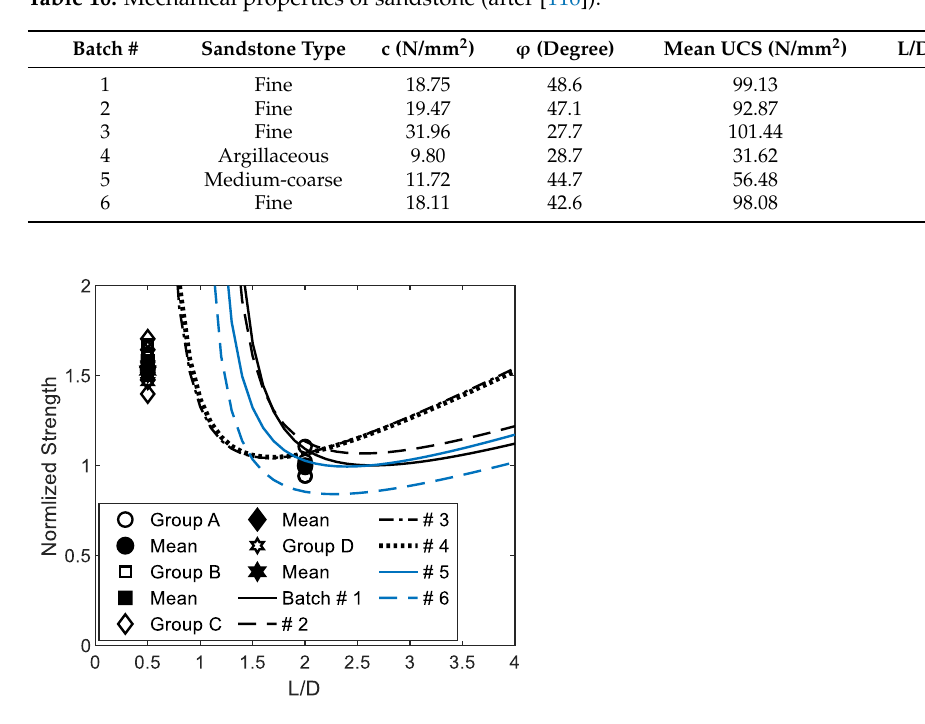
Figure 15. Normalized strength with theoretical expression.